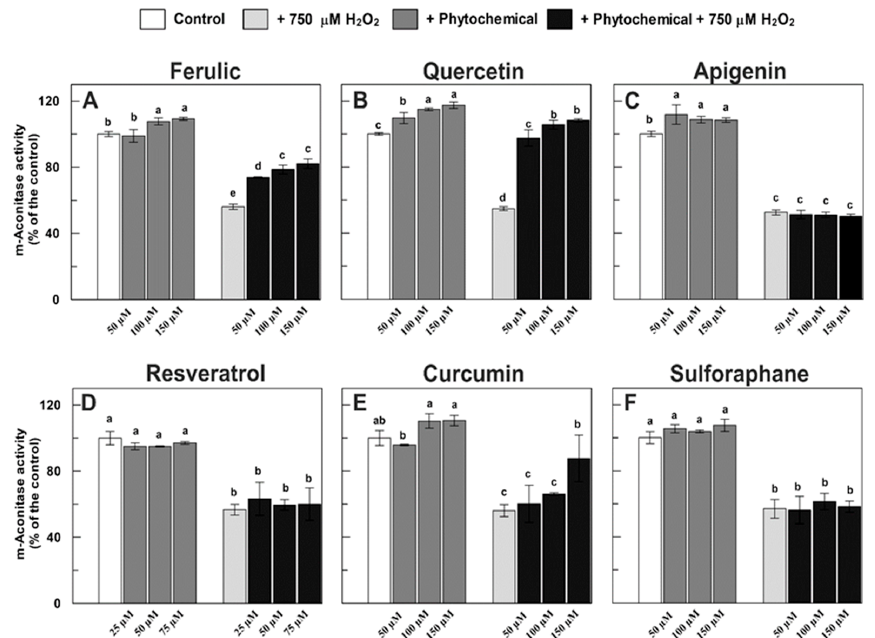
Figure 3. Effect of different phytochemicals on m-aconitase activity, both untreated and treated